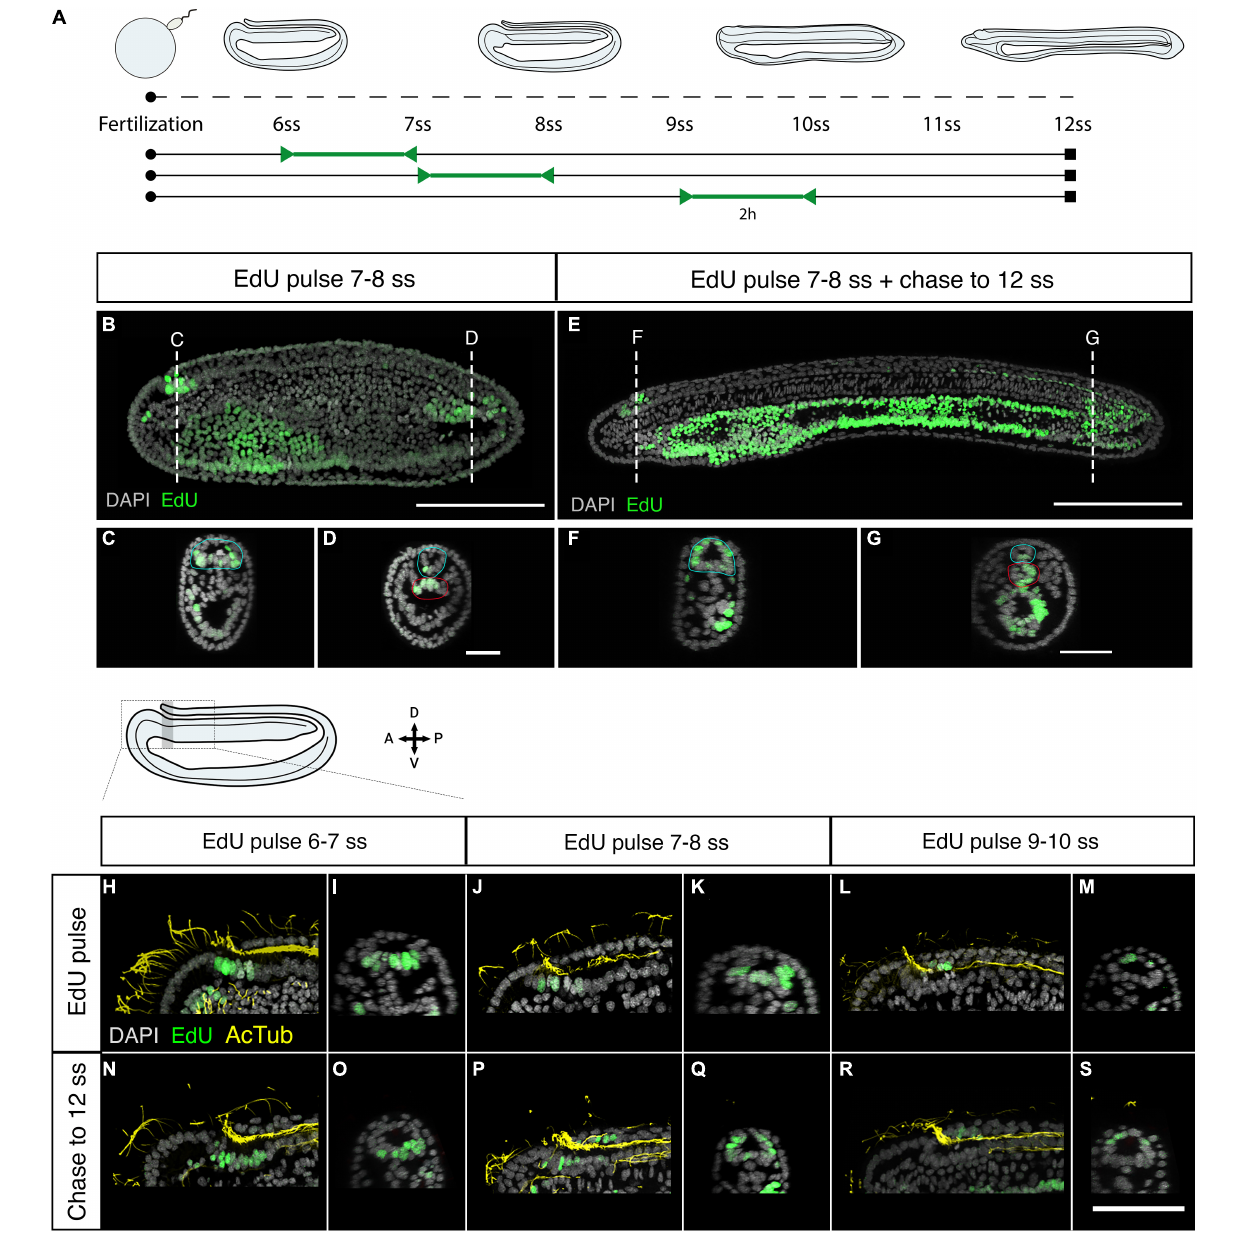
FIGURE 2 | Fate of proliferating cells tracked using EdU-pulse chases. (A) Experimental design of Edu pulse-chase experiments. Two-hour EdU pulses are represented in green, after which embryos were raised (chase) to 12 ss and then fixed (square). (B) Detection of EdU-pulse between 7–8 ss with cross section details shown for the anterior (C) , and the posterior (D) neural proliferative domains. (E) Chase of an embryo pulsed at 7–8 ss, as shown in panel (B) , to 12 ss revealing that while anterior EdU-positive cells remain in the brain (F) posterior positive cells spread through one-third of the posterior floor plate (G) . In cross sections the blue circle highlights the neural tissue while the red circle defines the chordoneural hinge (D) and the notochord (G) . Scale bar is 100 µ m for lateral views and 30 µ m for cross-sections. (H,I) EdU pulses at 6–7 ss marked ventral brain cells, as shown in lateral (H) and sagittal (I) planes, which remained ventral in the cerebral vesicle of 12 ss embryos, as shown in lateral (N) and sagittal (O) planes of the brain. (J–M) At later stages lateral and dorsal proliferating cells in the brain, as shown by Edu pulses between 7–8 ss [Panel (J) : lateral plane; (K) sagittal plane] and 9–10 ss [Panel (L) : lateral plane; (M) sagittal plane] contributed to progressively dorsal cell populations, as shown in embryos at 12 ss in lateral (P,R) and sagittal (Q,S) planes. EdU in green, acetylated tubulin in yellow. Scale bar is 50 µ m.